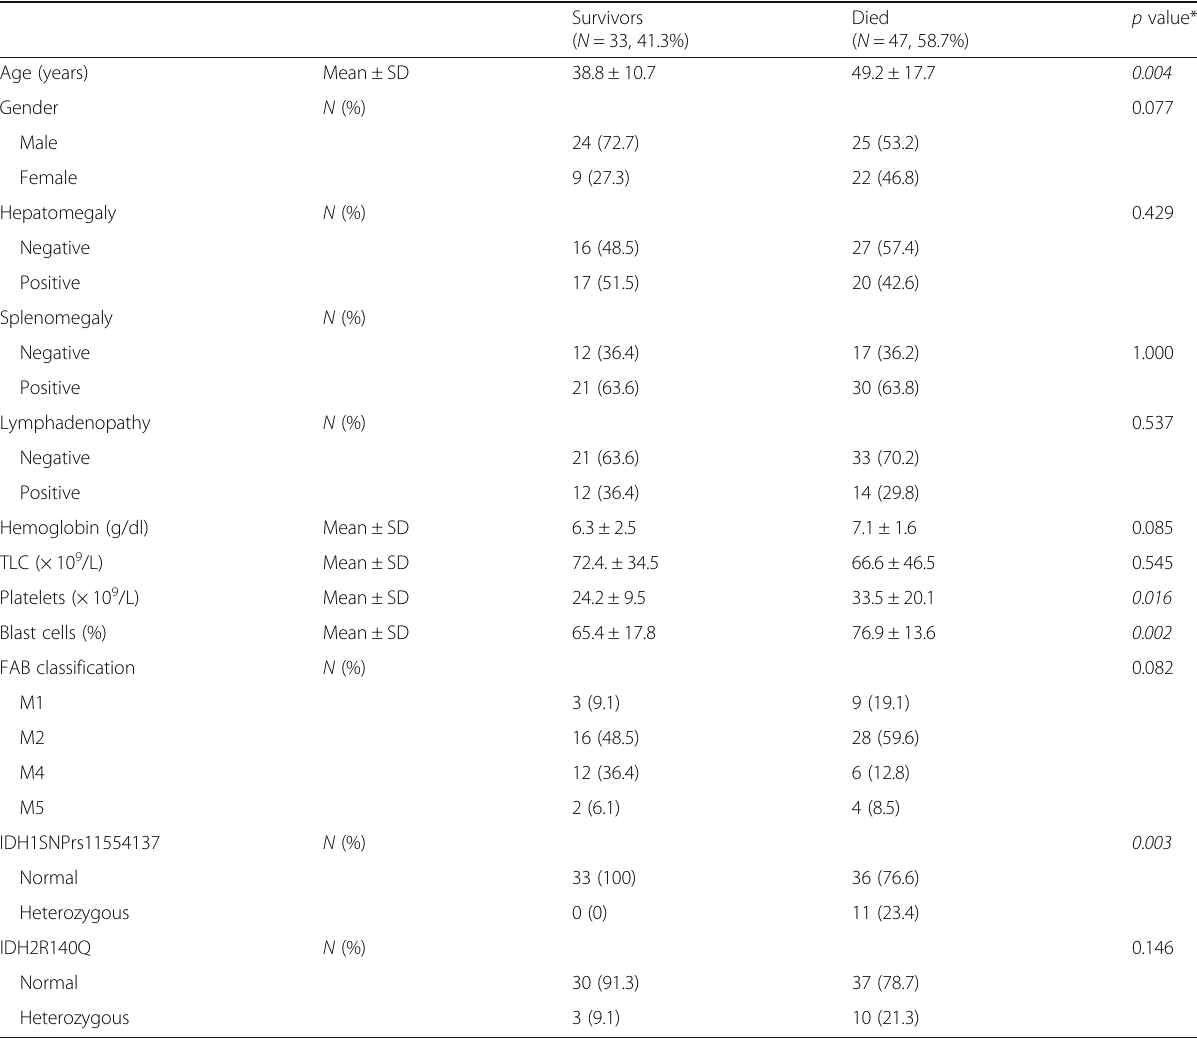
Table 5 Comparison between survivors and non-survivors at 6 months